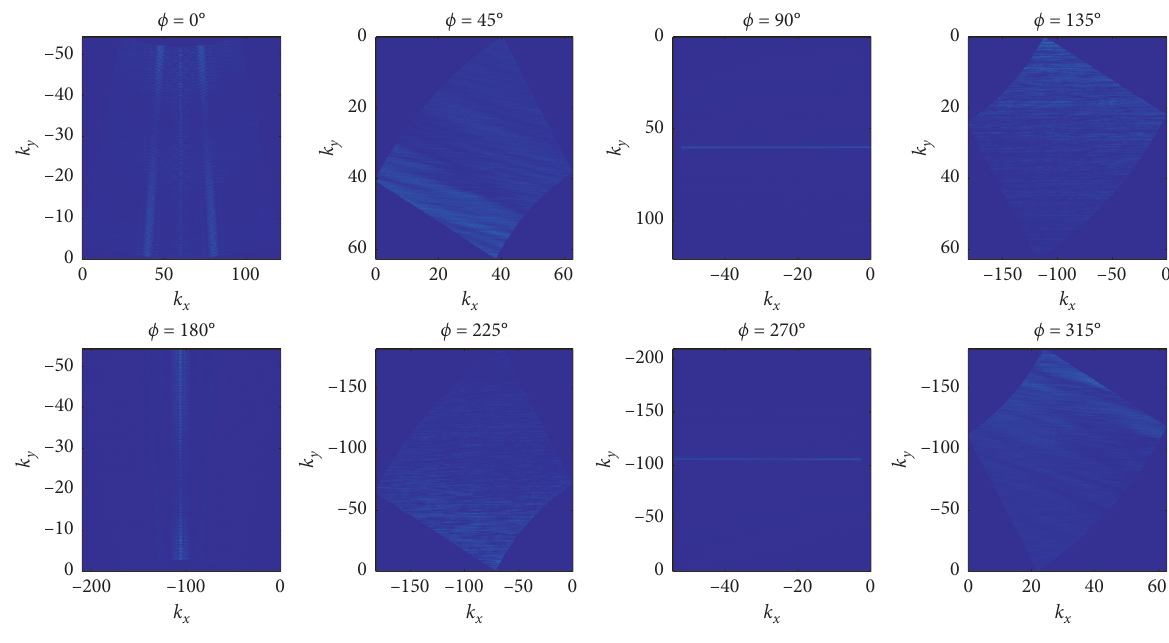
Figure 11: The backward scattering data in k